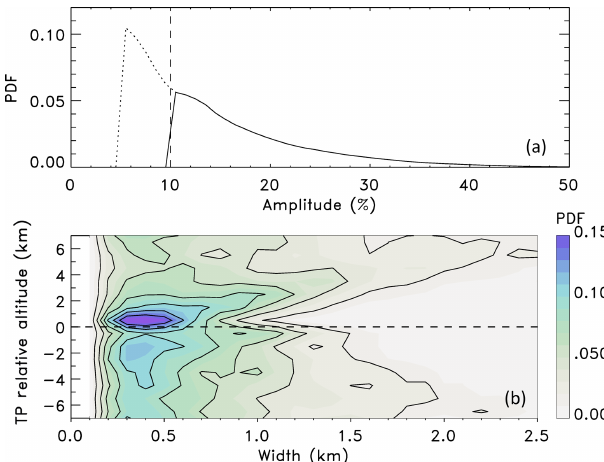
Figure 6. Probability density function (PDF) of the amplitude dis- tribution for all ozone laminae (a) and contour PDF of width dis- tribution for ozone laminae versus altitude relative to the WMO tropopause (b) . For the amplitudes, the standard 10% detection threshold is indicated by the vertical dashed line and the solid curve shows the amplitude distribution using this criterion. The dotted curve shows the extension of the amplitude PDF if a 5% detection threshold is employed. For the width PDF, contours are separated by 0.02, and the black dashed line indicates the tropopause